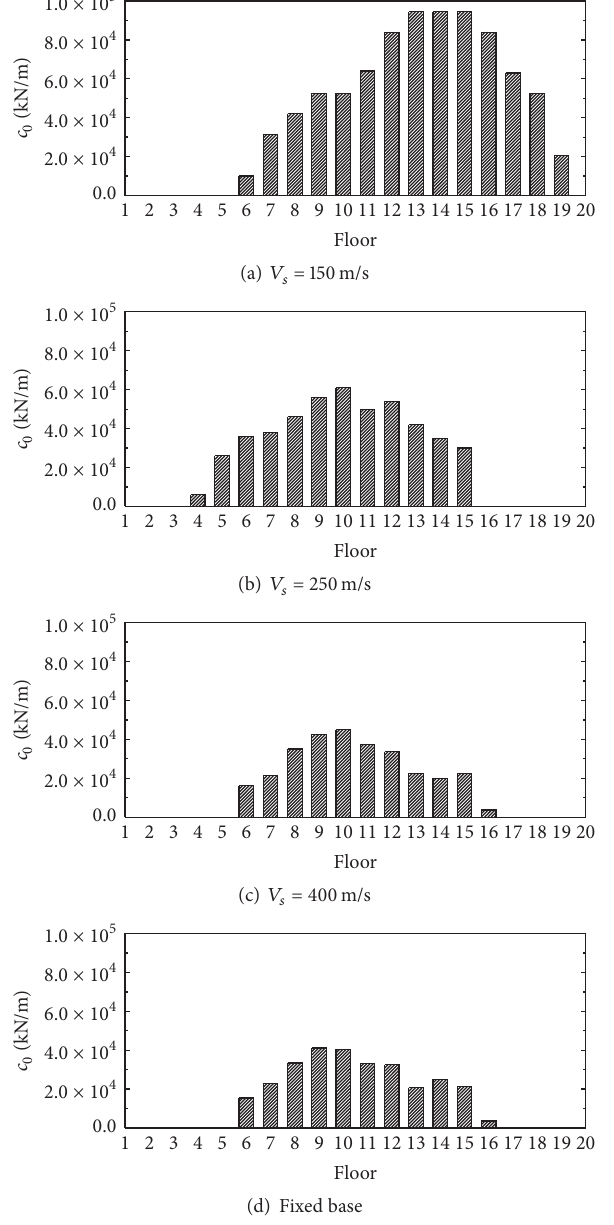
Figure12:TheoptimalplacementschemesofVEDsfordifferentsoil types (20-story structure, 𝐸/𝑅 = 1 ).